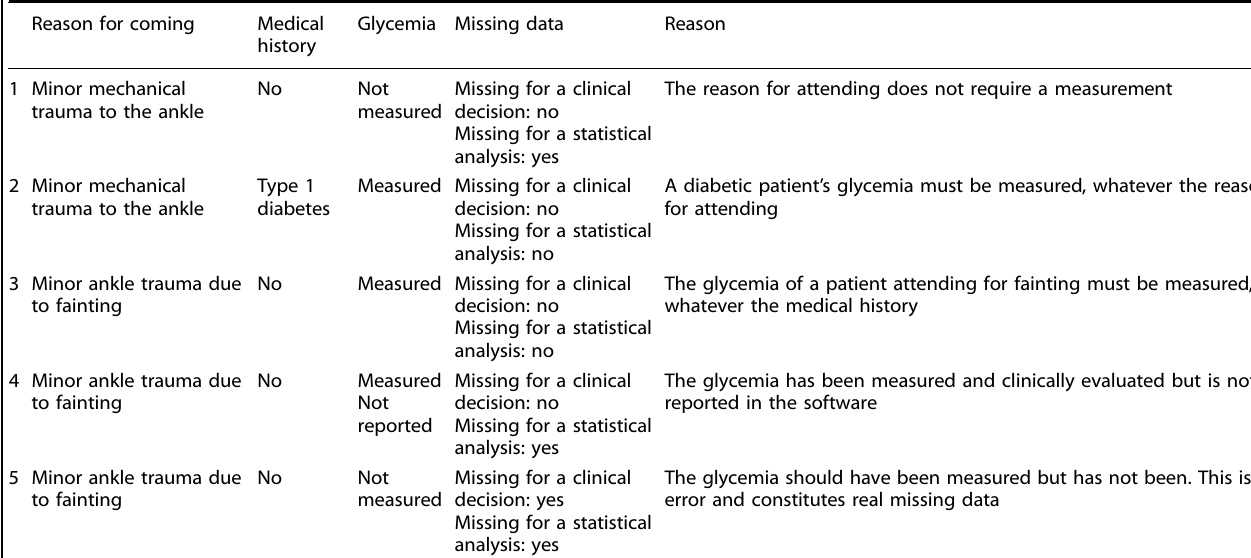
Table 1. Examples of how missing data can arise among patients attending the ED. Reason for